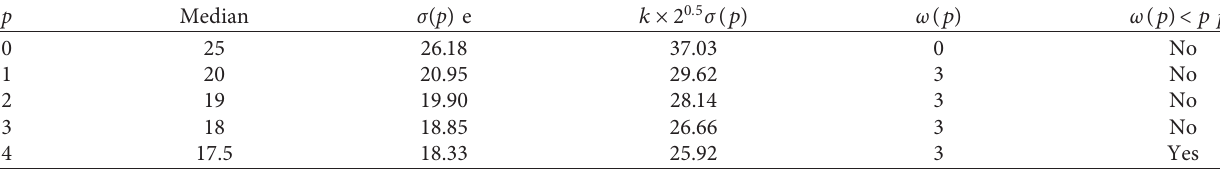
Table 17: step estimations for the investigation with the edge plan.